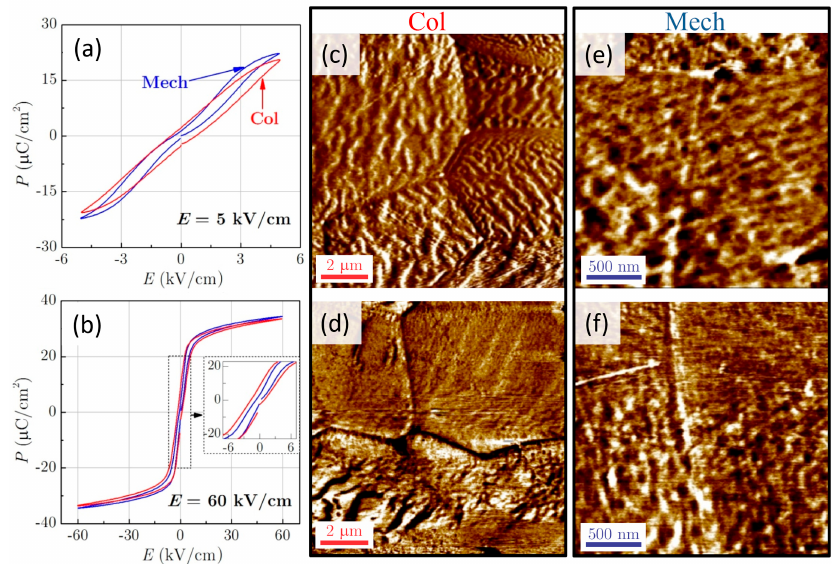
Figure 3. The P–E hysteresis loops at 27 °C for the Col (red line) and Mech (blue line) ceramics at electric field amplitudes of ( a ) 5 kV/cm and ( b ) 60 kV/cm. ( c – f ) The out-of-plane amplitude PFM images for the ( c , d ) Col and ( e , f ) Mech ceramics before (above; c and e ) and after (below; d and f ) poling. Note the different scales.